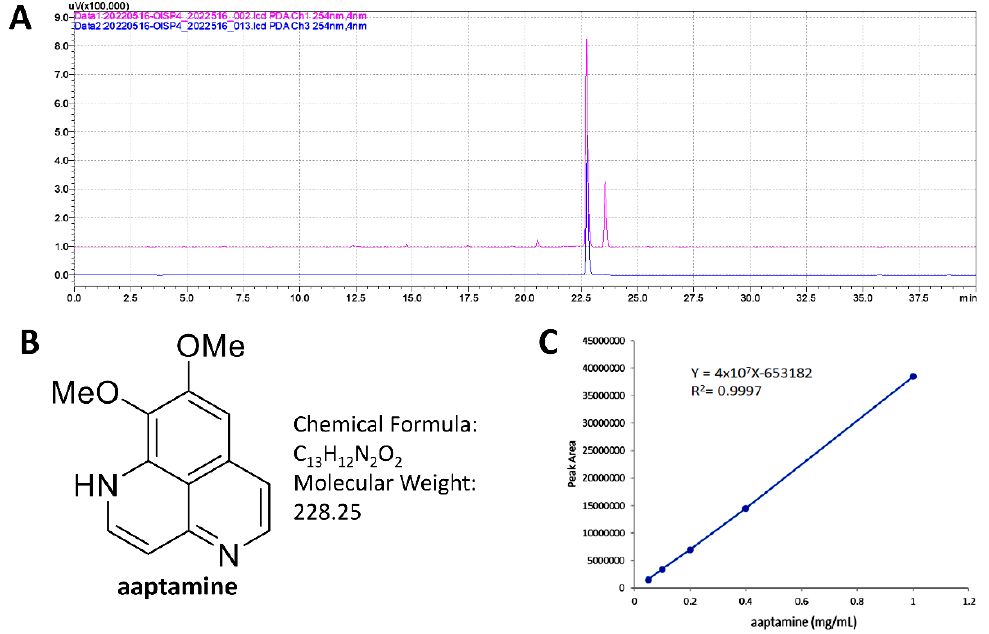
Figure 1. ( A ) The HPLC fingerprint profiles of MEAS and the main product of MEAS (aaptamine) were shown in red and blue, respectively. ( B ) Structure of aaptamine. ( C ) The calibration curve of aaptamine ( n =